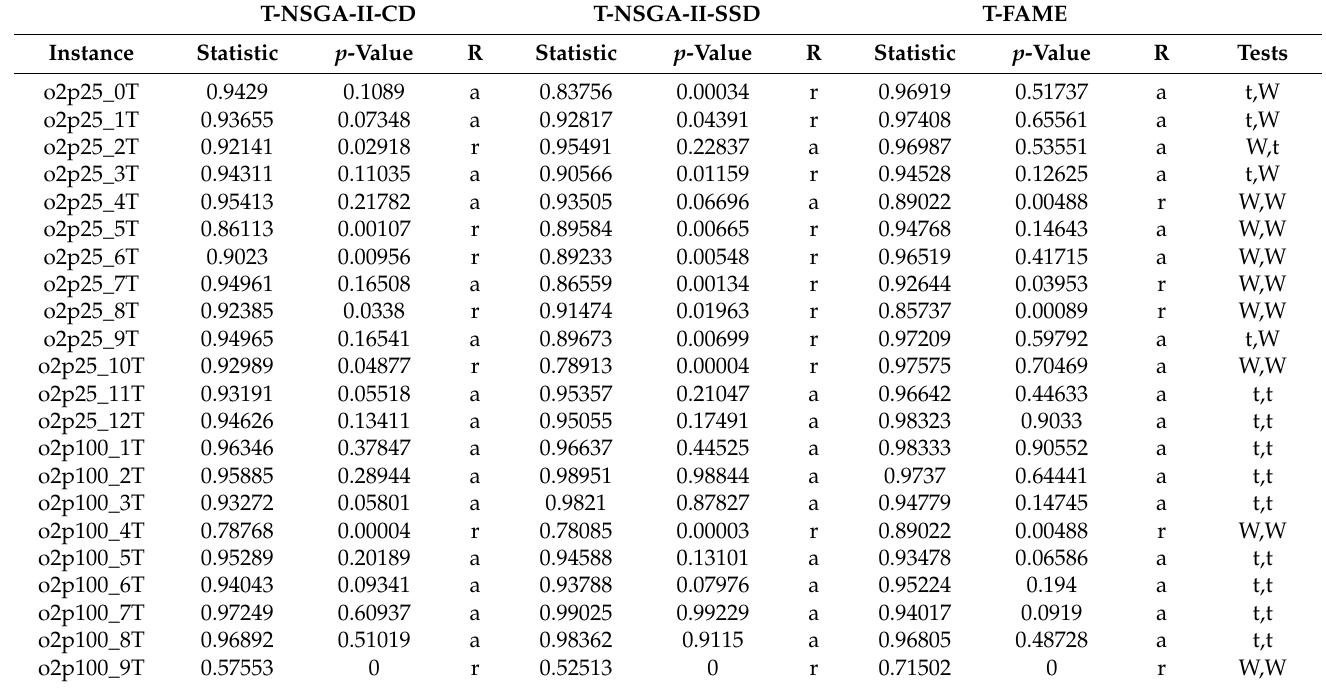
Table 6. Hypervolume normality test, the null hypothesis is that the samples follow a normal distribution which is accepted (a) when p -value < 0.05 and rejected (r)